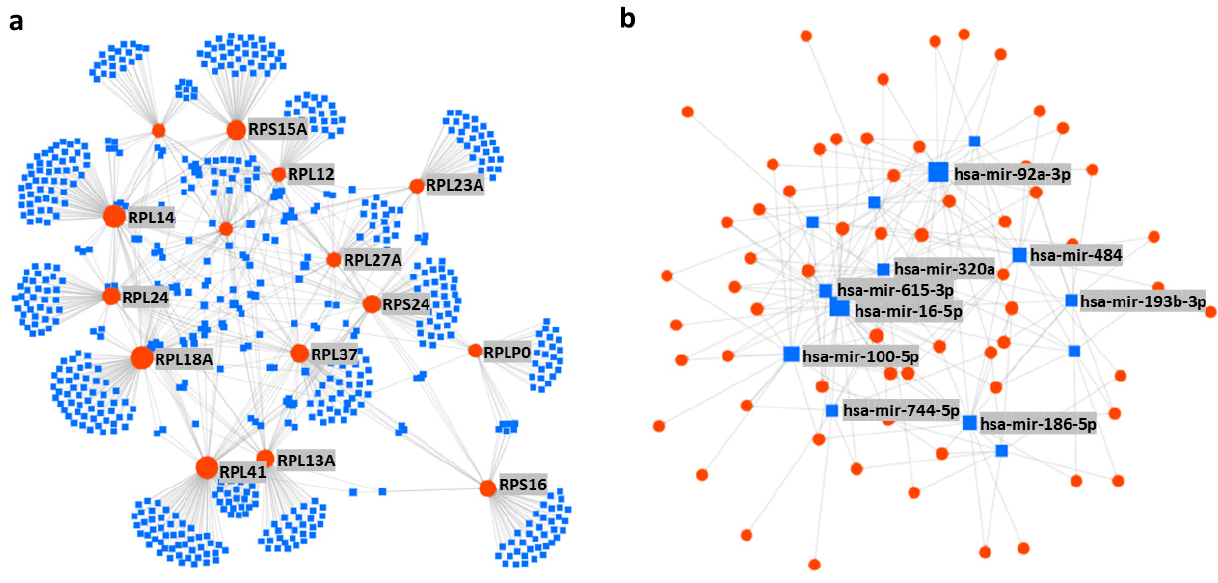
Figure 3. Interaction network between ribosomal proteins (RPs) and microRNAs (miRNAs). ( a ) Top 15 RPs are grouped based on their number of connections to the miRNAs (RPL41, RPL14, RPL18A, RPS15A, RPL13A, RPL24, RPS24, RPL37, RPS16, RPL12, RPS27A, RPS19, RPL27A, RPL23A, and RPLP0, respectively), and these 15 RPs are predicted to be connected by 670 miRNAs. ( b ) Top 14 miRNAs are grouped based on their number of connections with the RPs (hsa-mir-16-5p, hsa-mir-92a-3p, hsa-mir-100-5p, hsa-mir-615-3p, hsa-mir-484, hsa-mir-186-5p, hsa-mir-320a, hsa-mir-193b-3p, hsa-let-7a-5p, hsa-mir-331-3p, hsa-mir-92b-3p, hsa-mir-652-3p, hsa-mir-766-3p, and hsa-mir-744-5p, respectively), and these 14 miRNAs are potentially connected with 66 RPs. The size of the nodes indicates the degree of connectivity; the bigger the node size, the higher the connection. The interaction network was generated using the miRNet database (https://www.mir- net.ca/).